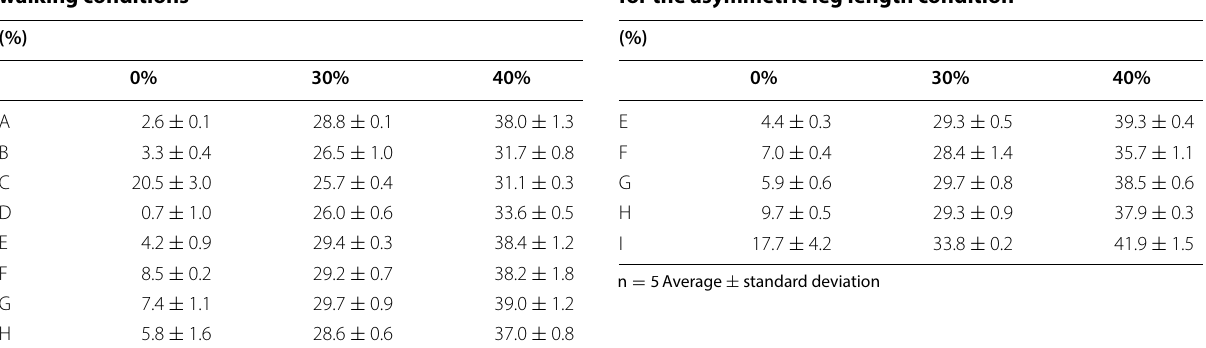
Table 4 Average of rUW at each